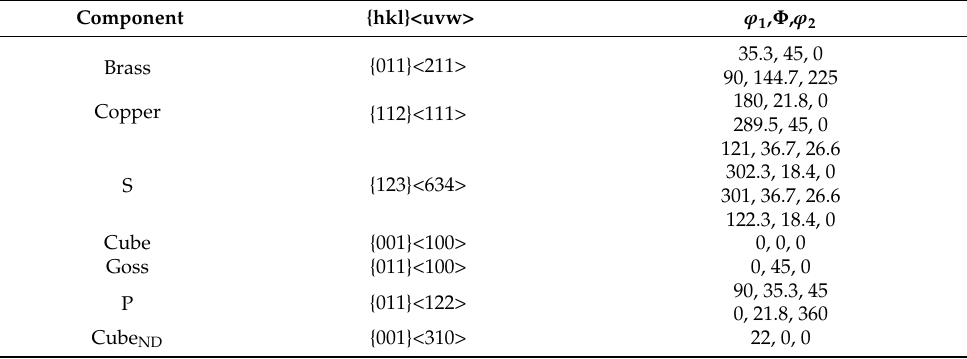
Table 1. Analyzed texture components with respective ideal orientations and Euler angles